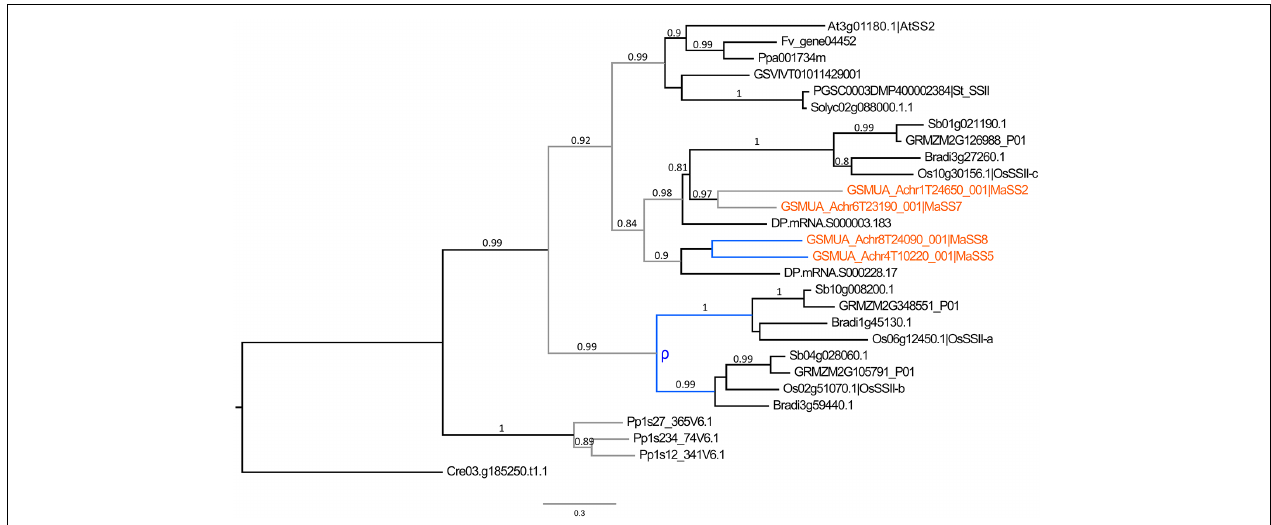
FIGURE 4 | Phylogenetic tree of SSII predicted proteins. The maximum likelihood tree of SSII predicted proteins was rooted using a Chlamydomonas reinhardtii (Cre) SSII sequence. Branch supports > 0.70 (aLRT statistics with SH–like procedure) are indicated. Physcomitrella patens (Pp), Grapevine (GSVIV), tomato (Solyc), potato (PGSC), strawberry (Fv), Arabidopsis (At), peach (Ppa), Brachypodium (Bradi), rice (Os), maize (GRMZM), sorghum (Sb), date palm (DP) and banana (GSMUA) identifiers are indicated (in brown for banana). Branches are colored according to gene duplication modes: WGD (blue) and unknown (gray). WGD events identified using reconstructed ancestral blocks are indicated (blue letters). Black branches correspond to speciation events. The scale bar corresponds to estimated amino acid substitutions per site.